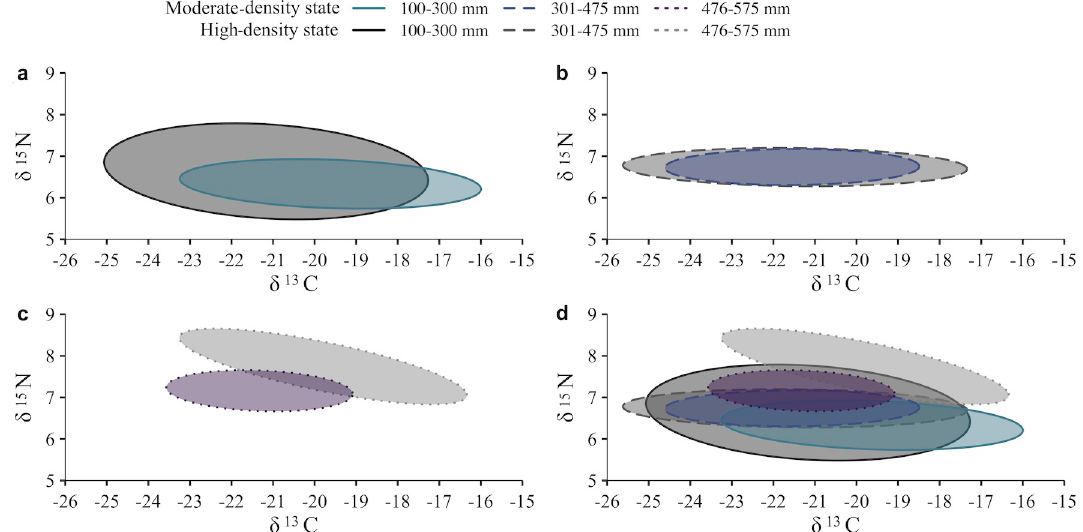
Fig 7. Stable isotope ellipse overlap for Yellowstone cutthroat trout in two lake trout density states. Standard Bayesian ellipse area 40% core distribution of stable isotope signatures for Yellowstone cutthroat trout from a lake trout moderate-density state (purple-blue hues) and a lake trout high-density state (Syslo et al. [53]; grey hues) among length classes: 100–300 mm (a), 301–475 mm (b), 476–575 mm (c), and all length classes (d). Relative abundances of lake trout are from Syslo et al. [55], where high density is ~450,000 > 300 mm lake trout, and moderate-density state is ~300,000 > 300 mm lake